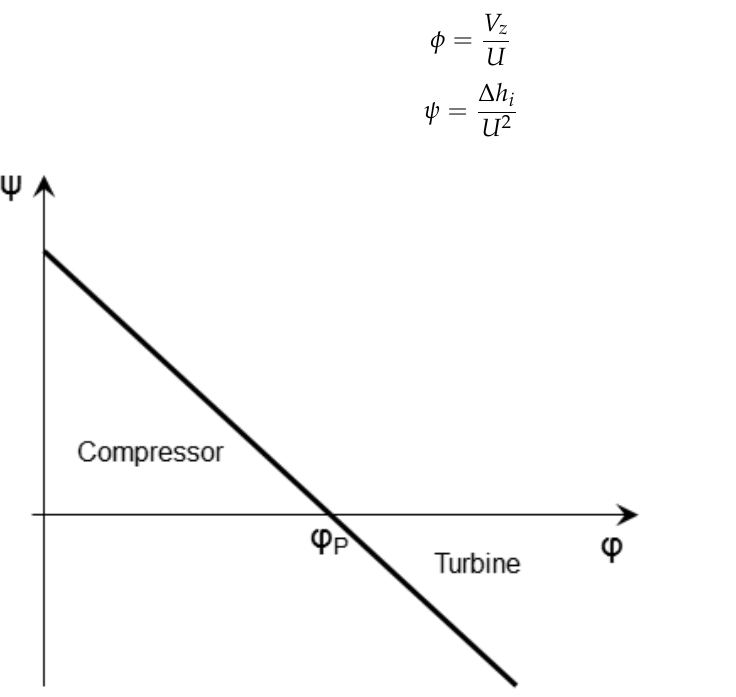
Figure 1. Performance curve plotted in the φ – ψ